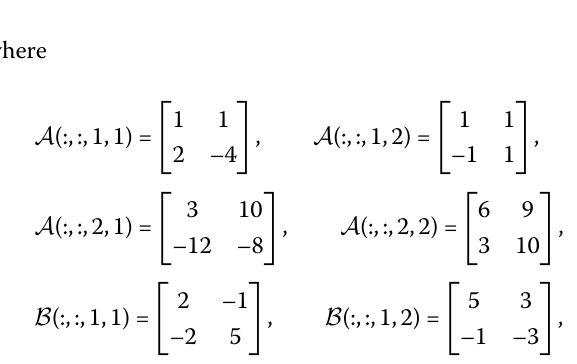
We set ˜ η = 0.5, k = 1. The residual error (cid:9) E ( t ) (cid:9) generated by NTCTZNN3 with γ 1 = γ 2 = 2 is displayed in Fig. 5, and the final residual error is 9.8868 × 10 –5 . Furthermore, its